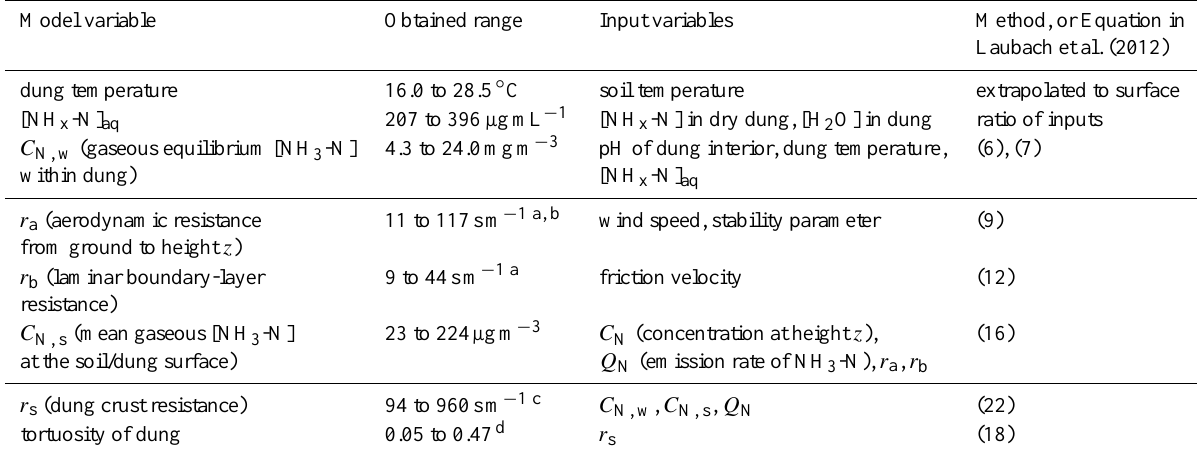
Table 2. Estimation of variables required for a resistance-model description of the NH 3 volatilisation from dung pats, analogous to that for urine-treated soil patches by Laubach et al. (2012), for Days 6 to